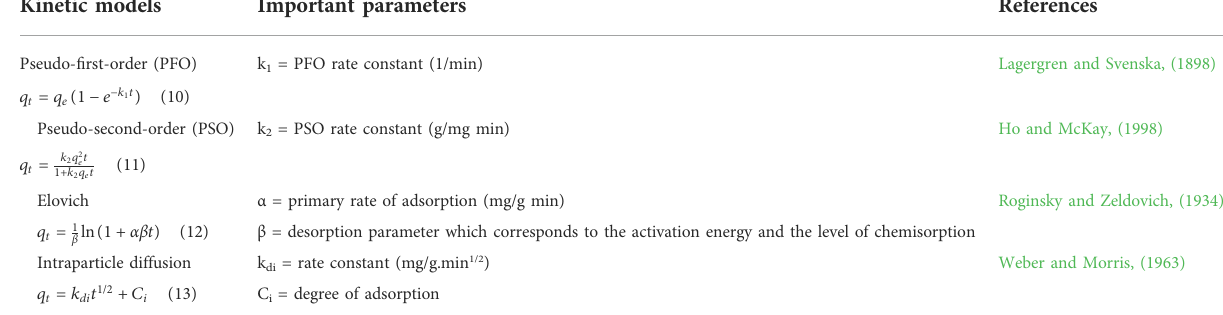
TABLE 8 Summary of kinetic models employed in dye-DPR-based AC adsorption